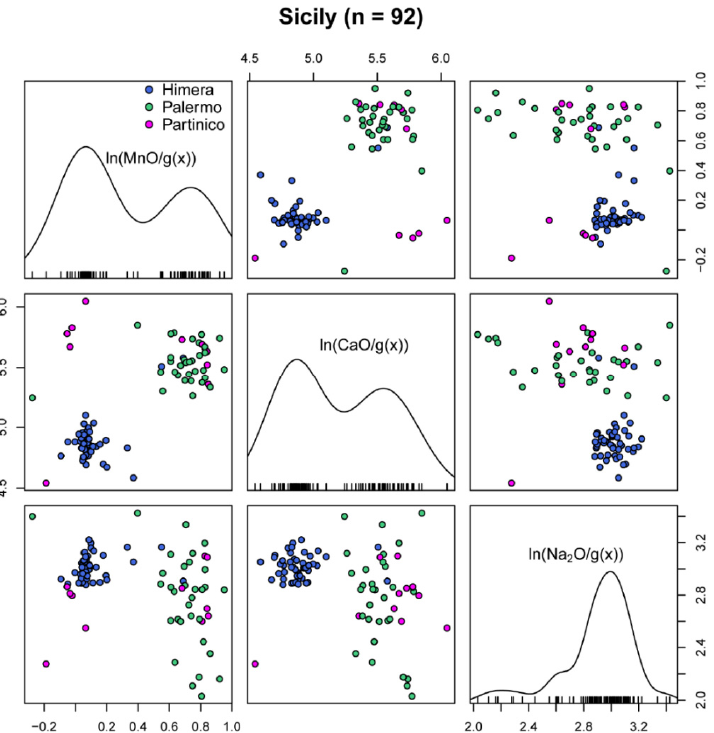
Figure 5. Scatterplot matrix on clr-transformed data using the three components that introduce most variability: MnO, CaO, and Na2O. In the diagonal, KDE of these clr-transformed components. Individuals are grouped by site